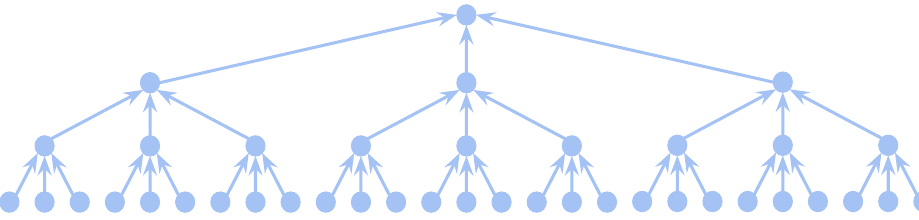
Figure 3. Data flow in the proposed S-TCN model, from bottom input to top